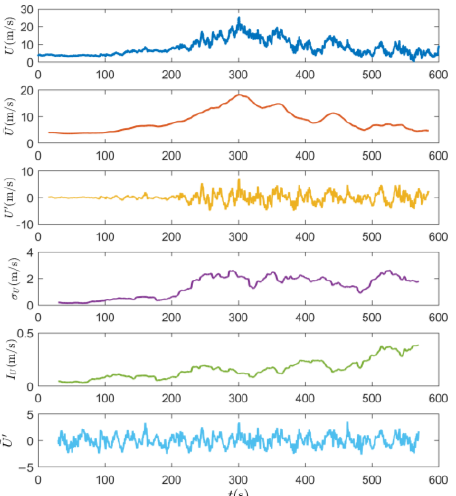
Figure 1. Decomposition of thunderstorm outflow wind speed based on the classical